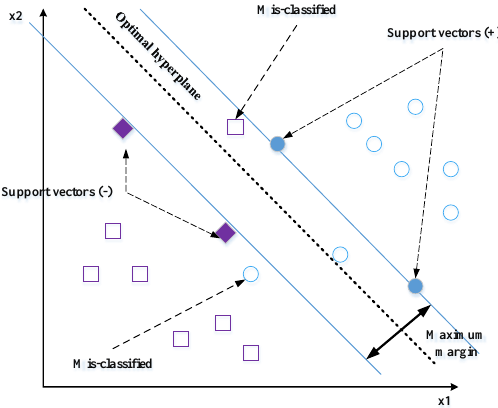
Figure 14. Optimal hyperplane, support vectors, and maximum margin.